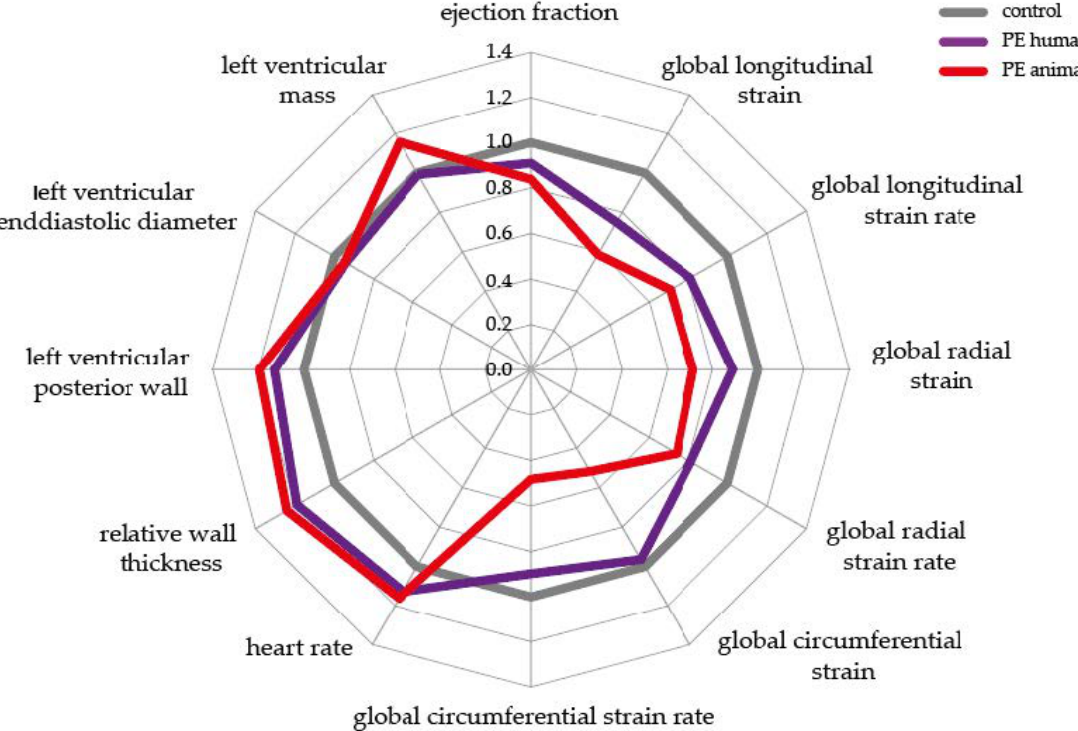
Figure 3. Relative values of post-preeclamptic changes in the animal model and in the human situation. Controls of each species were normalized to one. Grey line = controls, purple line = PE human, red line = PE animal; PE preeclampsia.